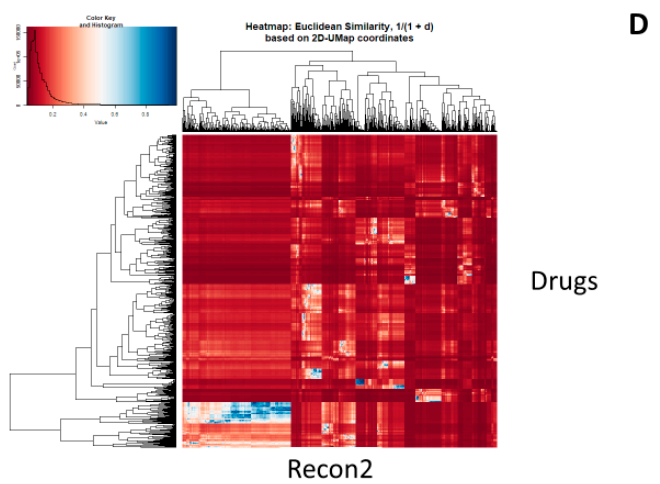
Figure 3. Top similarities between drugs and metabolites as judged by a fingerprint encoding (RDKit patterned) and our new VAE-Sim metric. ( A ) Rank ordering. ( B ) Heatmap for Tanimoto similarities using RDKit patterned encoding. ( C ) Heatmap of Euclidean similarities E-Sim (Equation (1)) for VAE- Sim in the 100-dimensional latent vector). ( D) Heatmap of Euclidean similarities EU-Sim (Equation (2)) for VAE-Sim in 2-dimensional uniform manifold approximation and projection (UMAP) space.